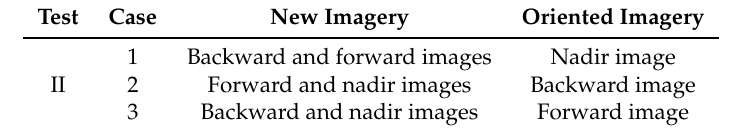
Table 6. ZY-3 datasets for direct georeferencing with the oriented imagery.